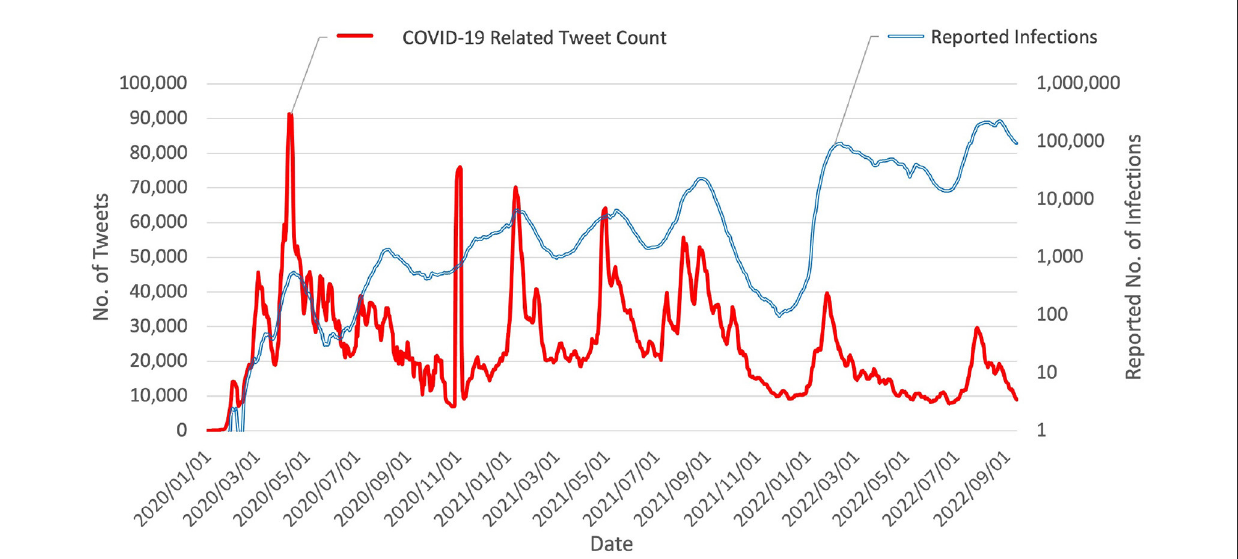
FIGURE2 Chart of daily tweet count vs. reported number of COVID-19 infections in Japan (values were smoothed using 7-day moving average). Data suggest that number of COVID-19 related tweets has been correlated to some degree with progression of the epidemic in Japan since its beginning. An abnormal surge of social media reaction was observed on 29 and 30 October 2020, which is close to Halloween. Otherwise, the social media reaction exhibits waves corresponding to the seven waves of COVID-19 epidemic in